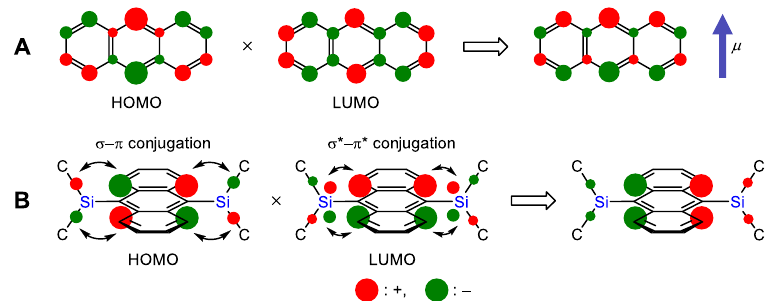
Scheme 1. Multiplication of the HOMO and LUMO of anthracene and the transition moment of the HOMO–LUMO transition ( A ). The effect of the silyl groups on the transition moment is shown in the ( B